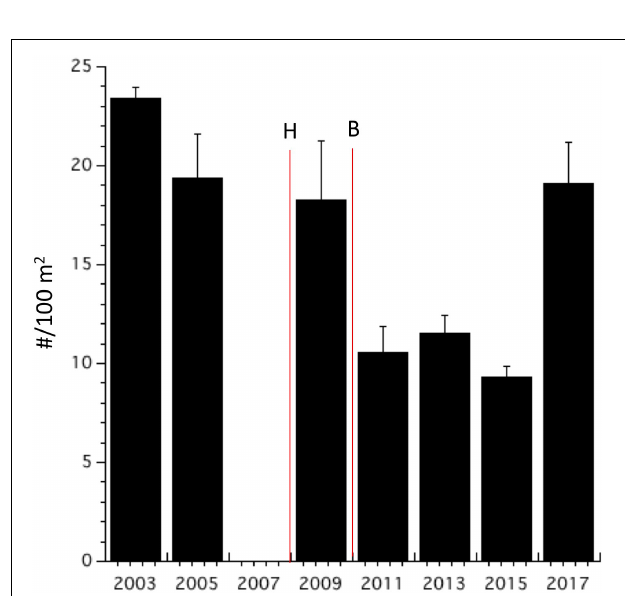
FIGURE 8 | Parrotfish population density (mean ± SE). Notations as in Figure 2